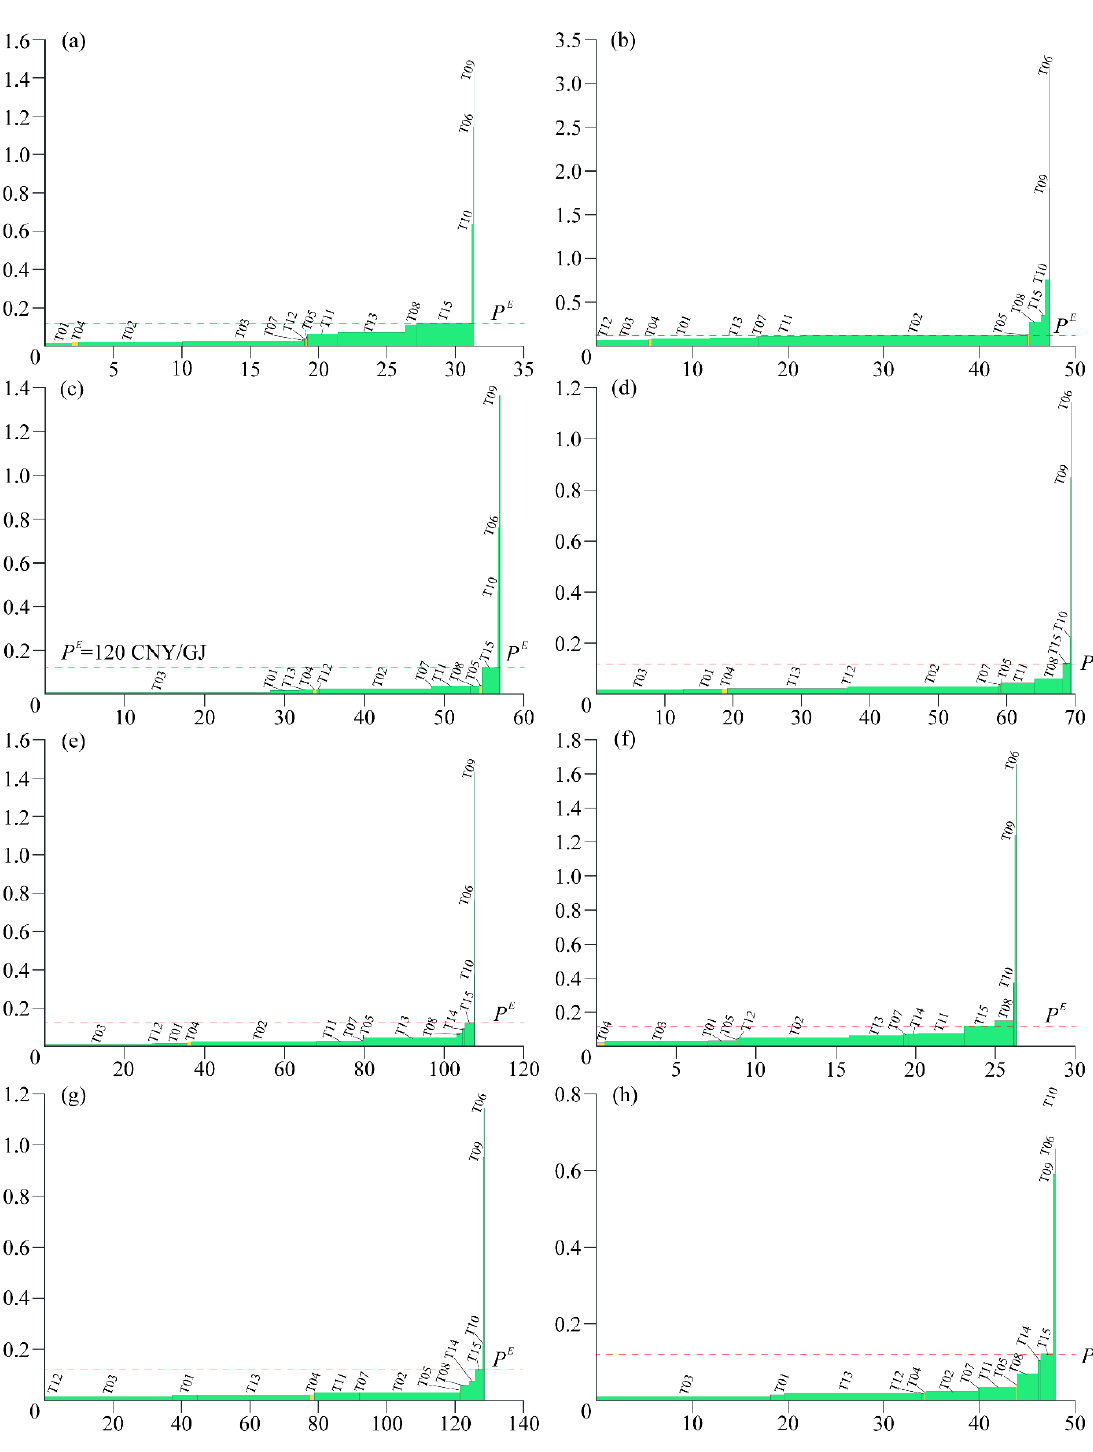
Figure 4. Energy conservation supply curve for the underground iron mines by either the caving (( a ) Xiaowanggou, ( b ) Yanqianshan, ( c ) Maogong, and ( d ) Shilu)), or backfilling methods (( e ) Luohe, ( f ) Wuji, ( g ) Lilou, and ( h ) Longtangyan)). The vertical axis is the unit cost for saving energy, in k CNY/GJ, and the horizontal axis is the cumulative energy conservation potential, in TJ/a. The dotted line in red represents the break-even price of energy (PE), which equals 120 CNY/GJ. The colors indicate the type of energy that the ECCA technology targets for conservation, i.e., green and yellow represent electricity and fossil fuel, respectively.